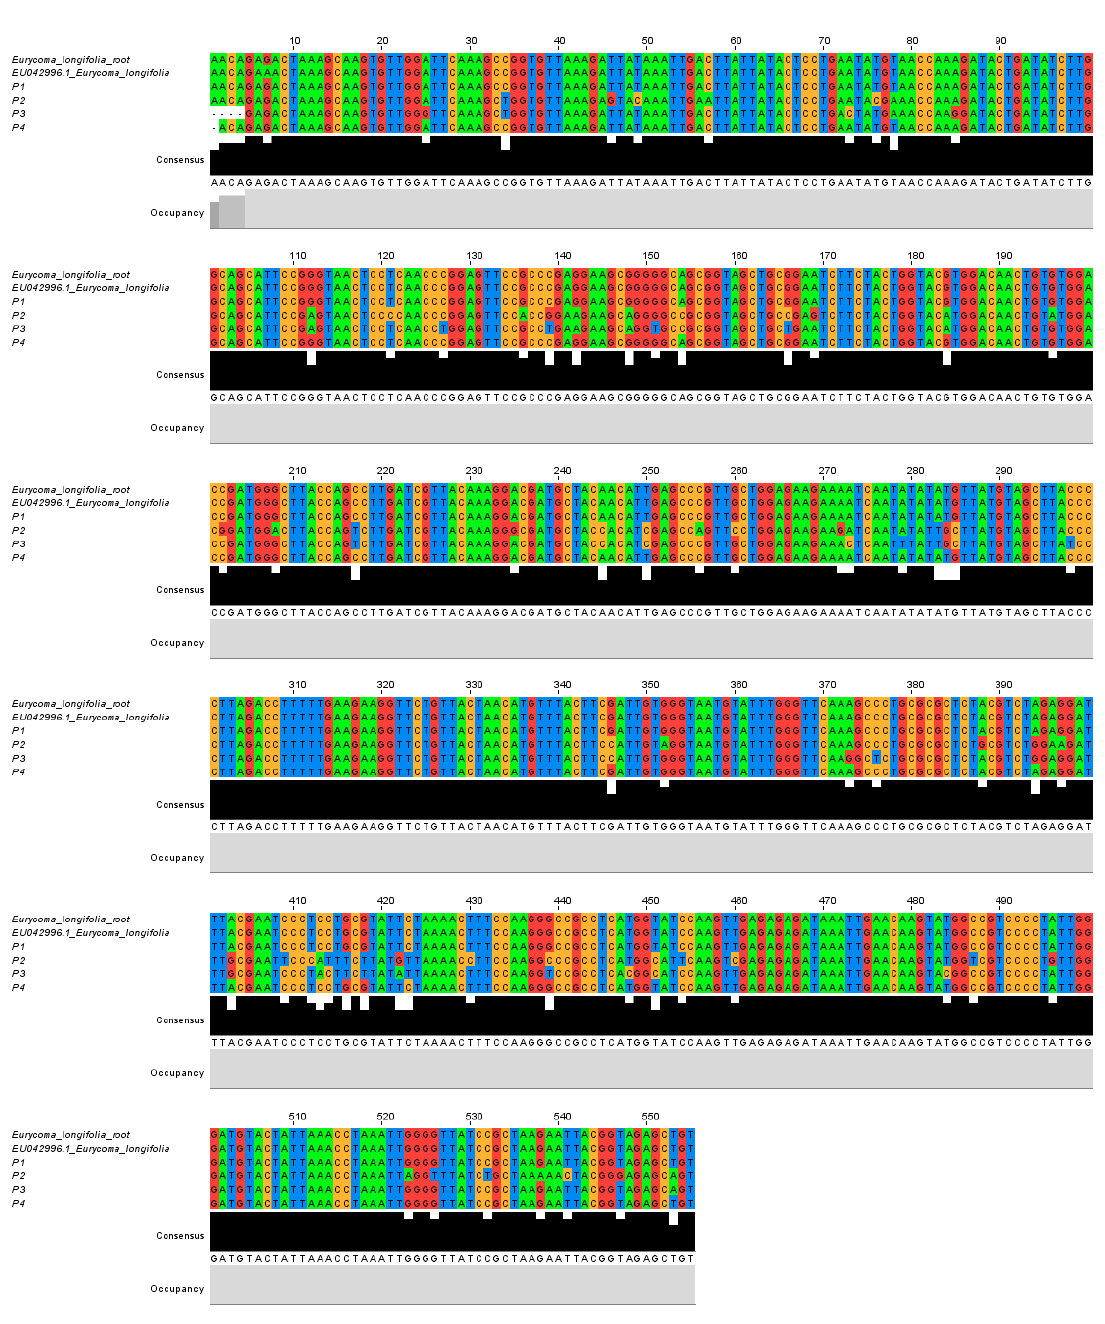
Figure 2. Multiple sequence alignment of rbcL between EU042996.1 E. longifolia extracted from NCBI database, E. longifolia root and four commercial herbal products: P1, P2, P3 and P4.